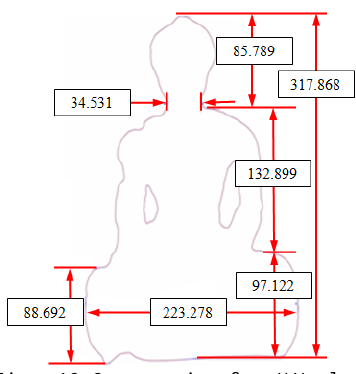
Figure 13. Cross-sections from XY-plane